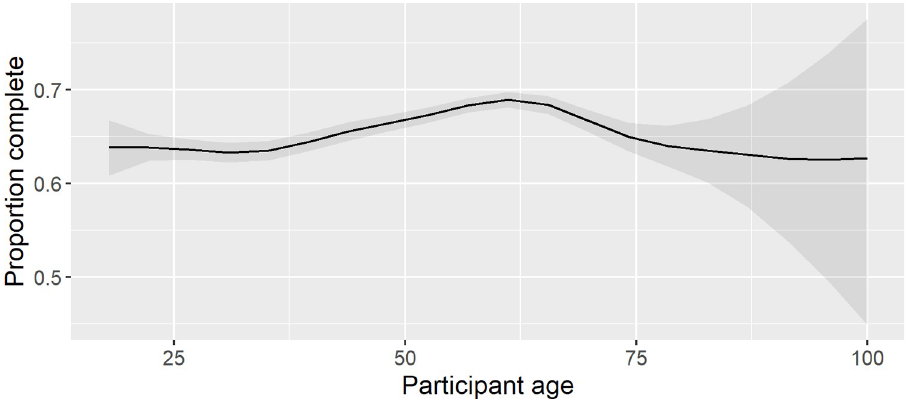
Fig 4. Proportion of participants at different ages who completed the Preventing Dementia